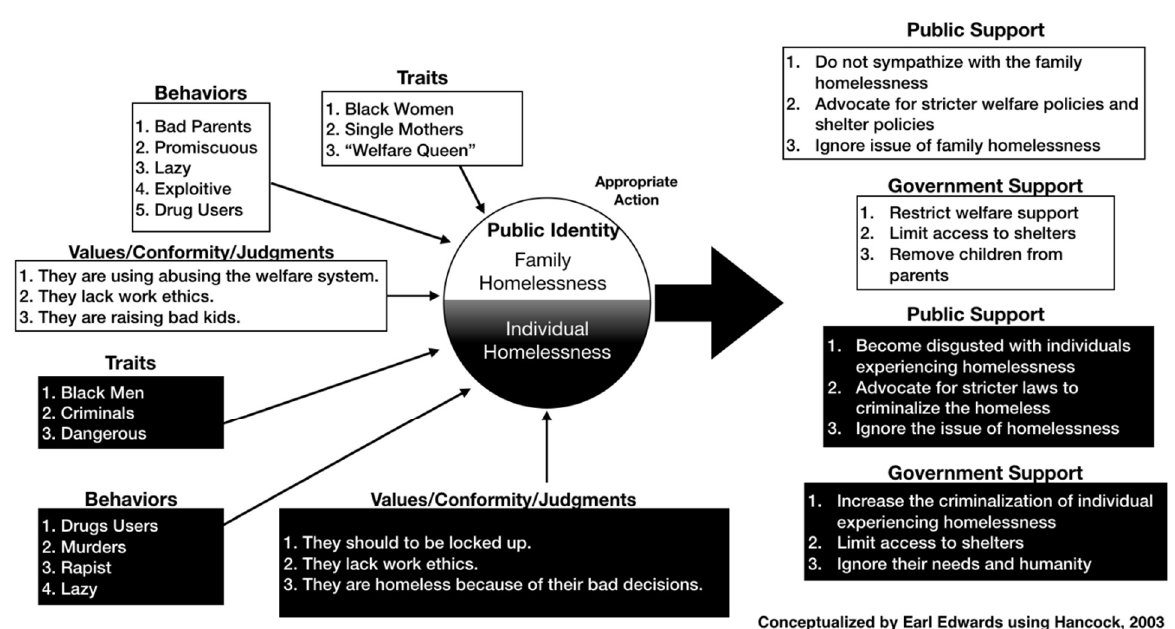
Figure 2. The underclass public persona for the homeless .